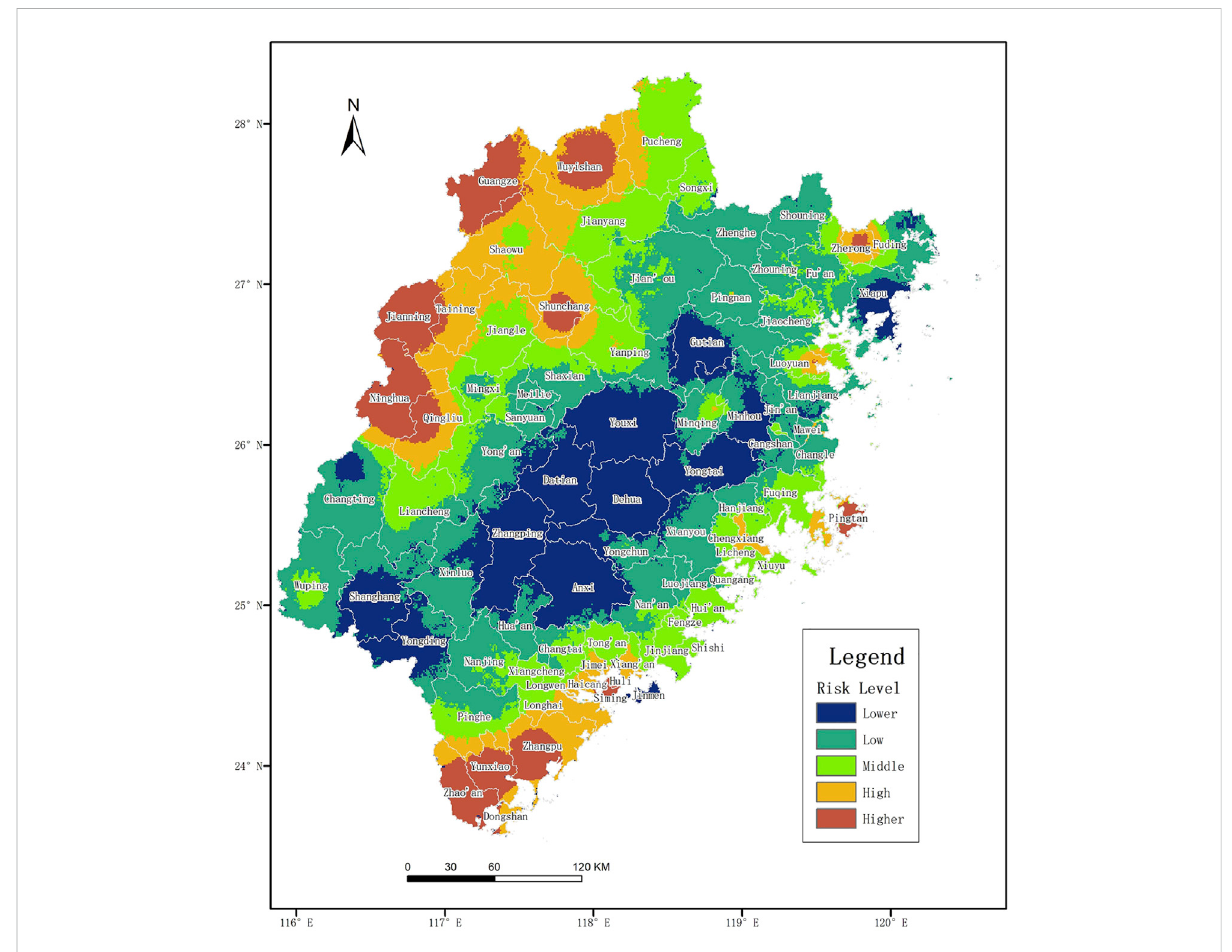
FIGURE 6 The spatial distribution pattern of the comprehensive risk of non-typhoon rainstorm